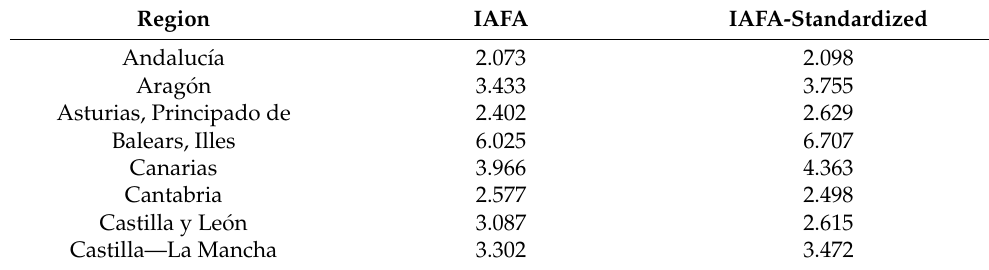
Table A4. IAFA and standardized IAFA sampling errors by